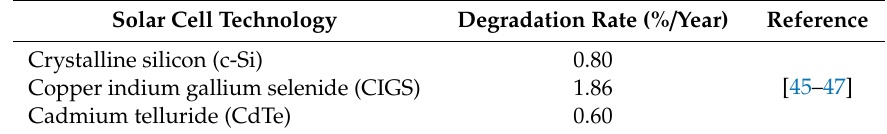
Table 8. The degradation rate of the chosen solar cell technologies as a photovoltaic leaf for the solar photovoltaic tree.